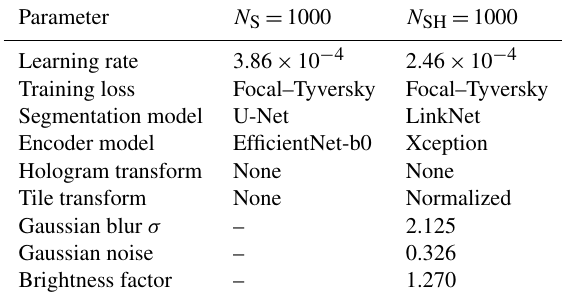
Table A1. The values of the best hyperparameters in the optimiza- tion studies for the neural segmentation models for the three species. The batch size was fixed at